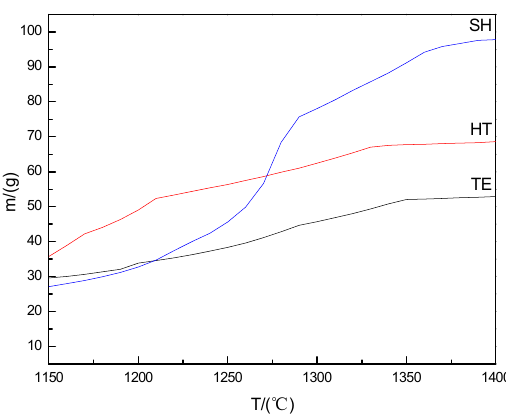
Figure 2. SEM and EDS ( c ) images of the samples prepared from PRL ( a ) and TE ( b ) at 1450 ◦ C for 2 h.